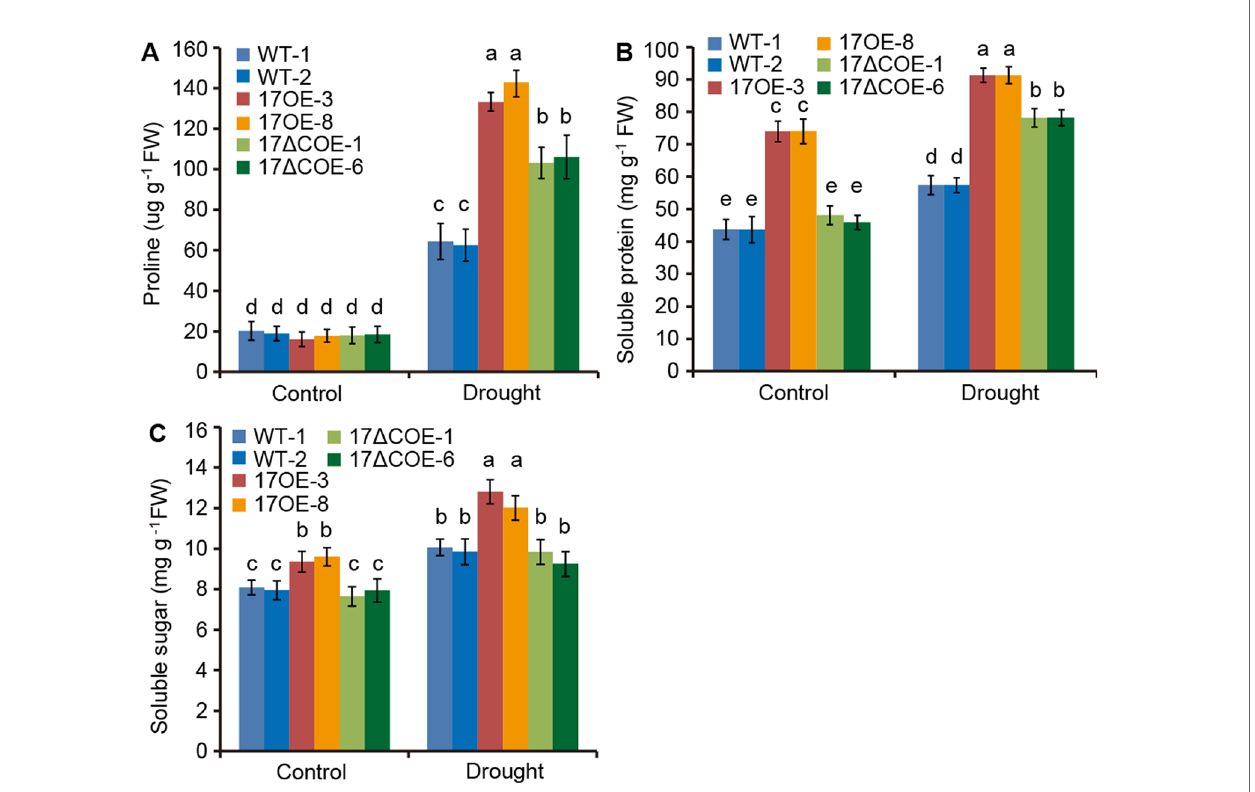
FIGURE 6 | Quantitative analyses of osmotic adjustment substances in 3-month-old WT, Pd C3H17OE (17OE), and Pd C3H17 D COE (17 D COE) poplars after well- watered or drought stress conditions for 20 days. (A) Free proline. (B) Soluble protein. (C) Soluble sugar. At least six plants of two lines in each genotype were measured. Data are presented as mean ± SD. Different letters above bars denote statistical signi fi cance between treatments of leaves ( P < 0.05). P <